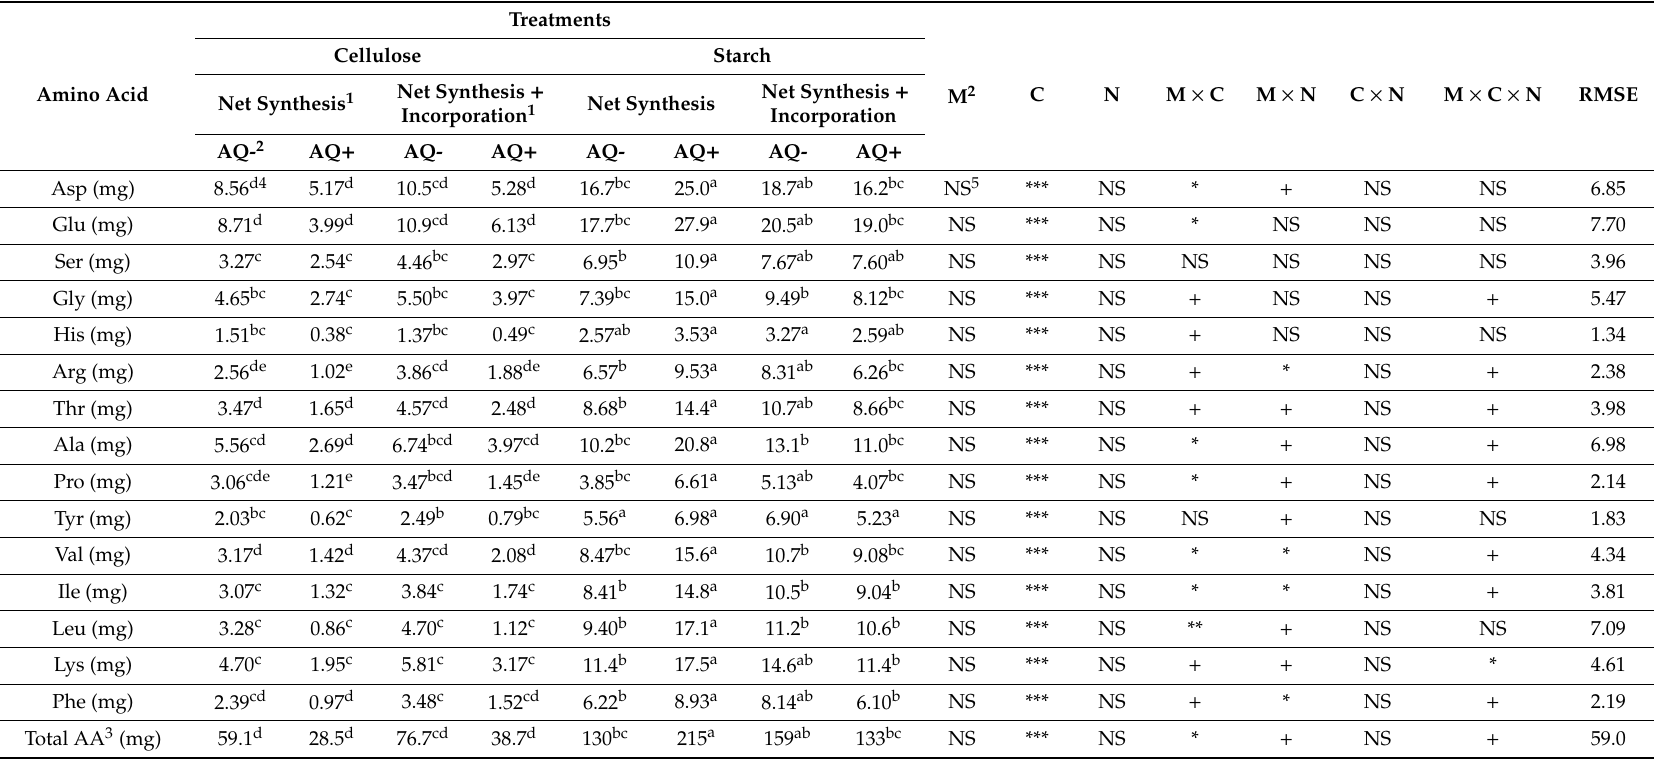
Table 3. E ff ects of the addition of 9, 10-anthraquinone to rumen batch cultures incubated with cellulose or starch as carbon and energy sources and ammonium or trypticase as sources of nitrogen on the net production of microbial amino acids.